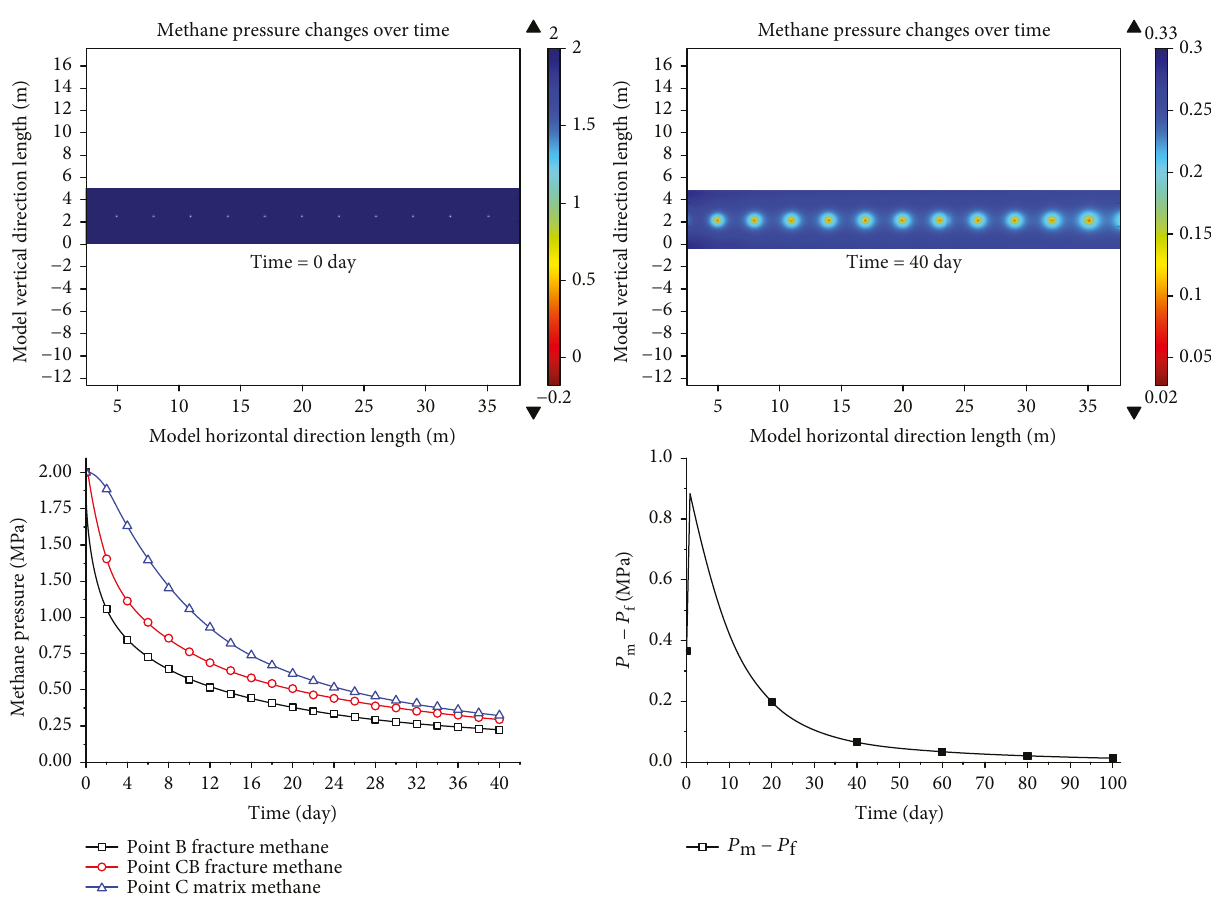
Figure 7: Coal seam methane pressure changes with time.